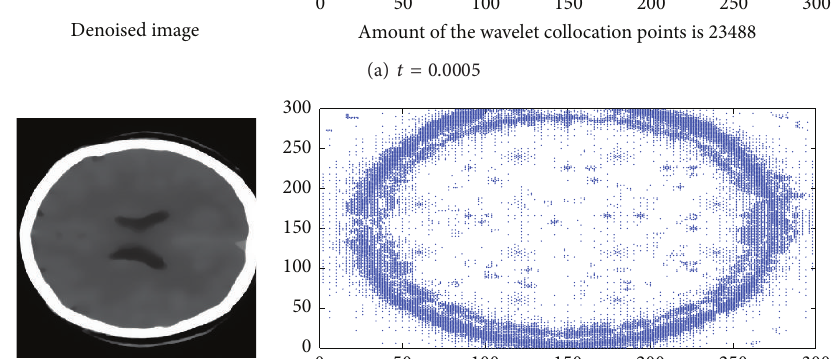
image anymore. The amount of the wavelet collocation points also decreased